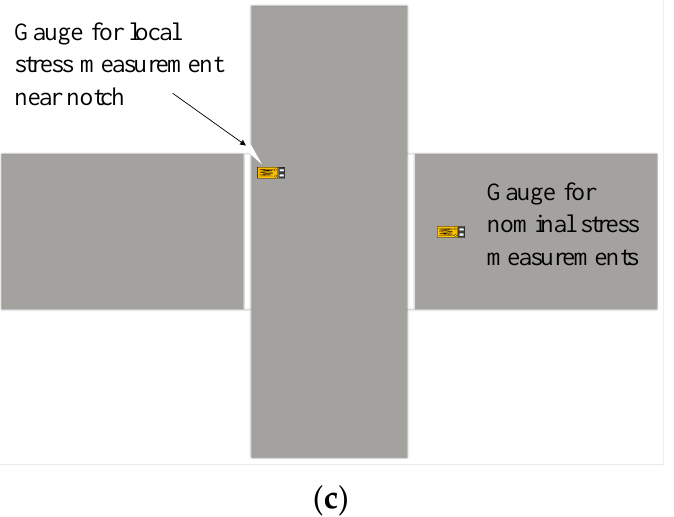
Figure 29. Strain gauge locations for the various specimen configurations: ( a ) full-scale axial, ( b ) full-scale 3-point, and ( c ) half-scale axial.